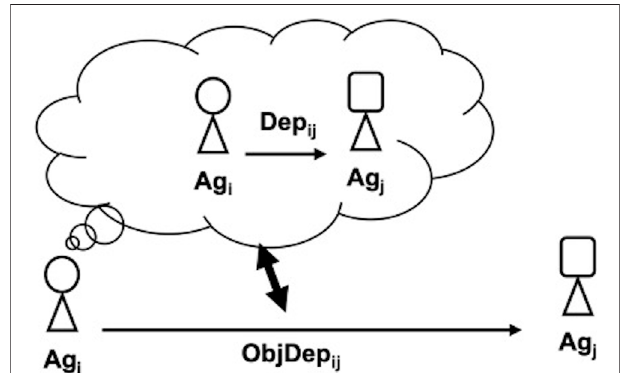
FIGURE2| DependenceofAg i byAg j onthetask τ .Comparisononhow it is believed by Ag i and objective reality.